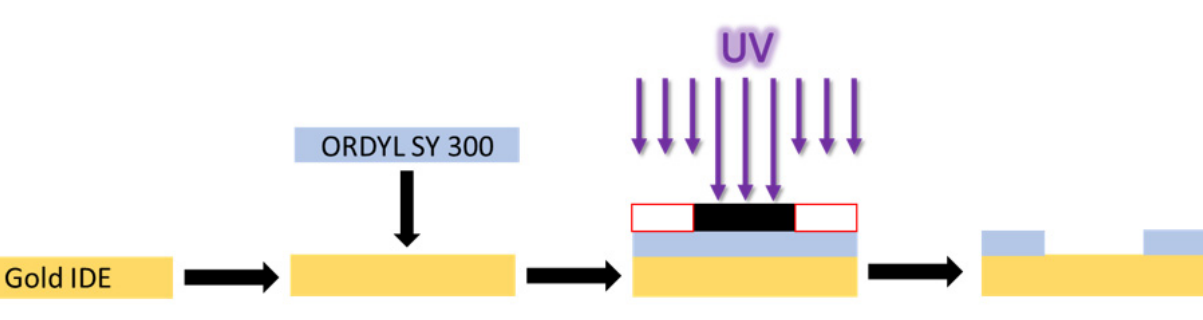
Figure 1. Coating and patterning ORDYL SY 300 at gold IDE surface.